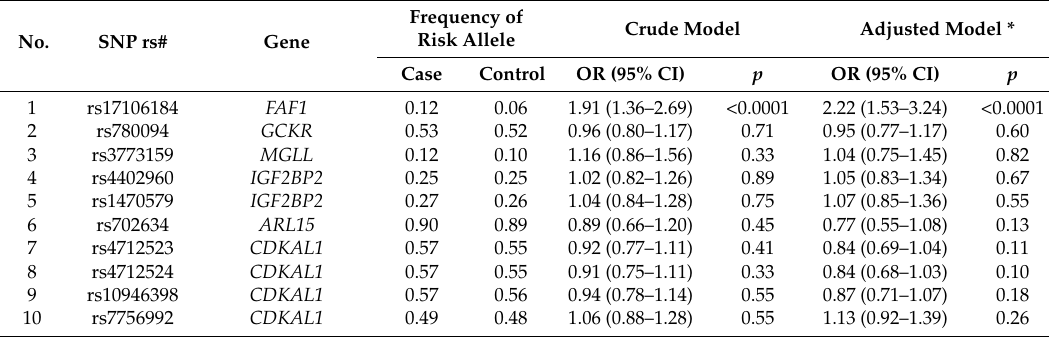
Table 2. Association of selected T2DM-related SNPs with T2DM